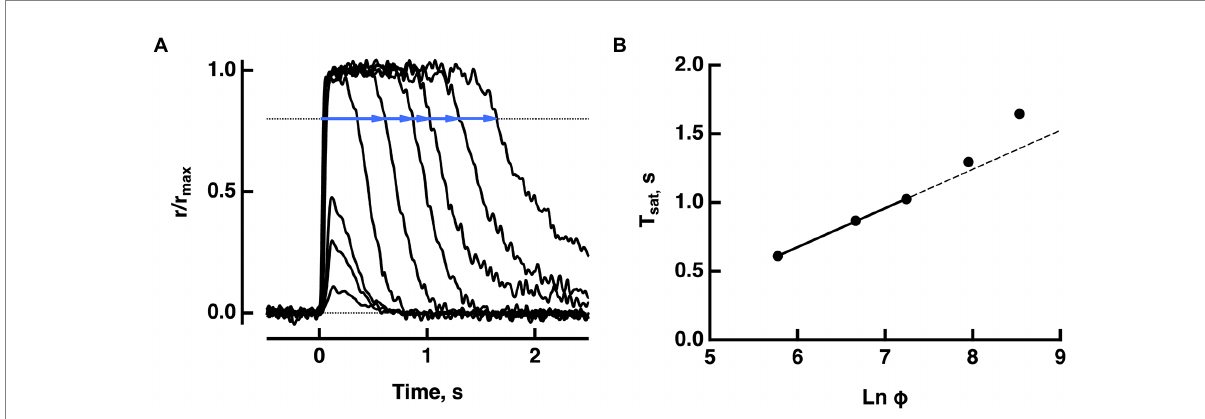
FIGURE 1 Pepperberg plot for a WT mouse rod. (A) Photocurrent responses of a rod to flashes of increasing strength, presented at time zero. For the brightest 5 flashes, saturation time ( T sat ) was measured from mid-flash to a criterion recovery of 20% (blue lines). (B) Pepperberg plot. Flash strength was converted to photoisomerizations ( Φ ), using a collecting area of 0.45 μ m 2 . The three shortest saturation times were fitted with a line; longer saturation times deviated from the line. The slope of the line τ D = 283 ms, provided an estimate of τ E*, the time constant for the shutoff of T * ——E. Adapted from Makino et al. (2008).